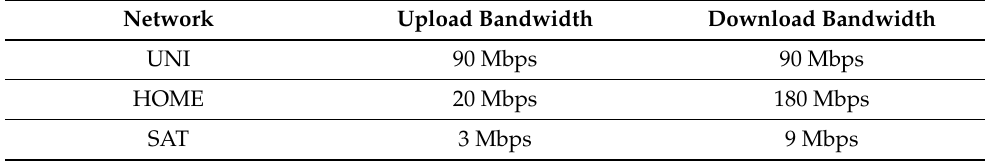
Table 3. Network connections under tests.